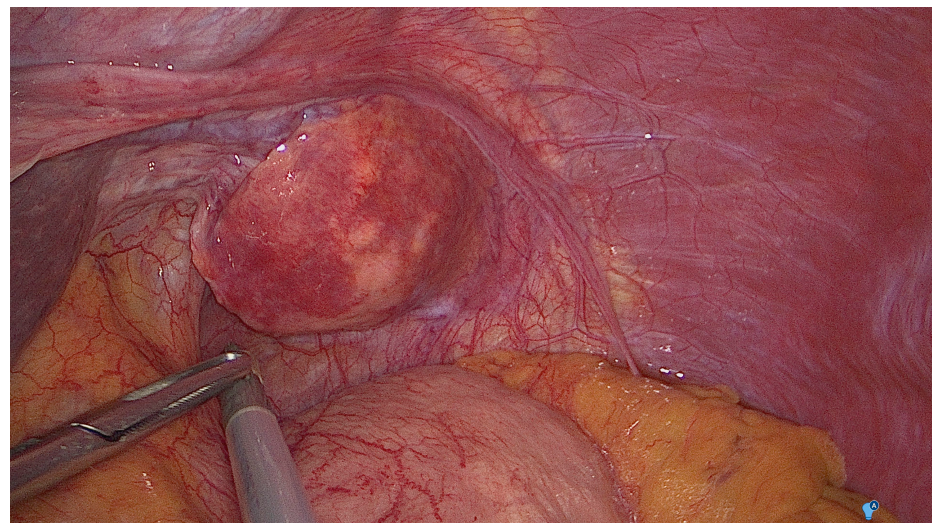
Figure 2. Intraoperative findings. Between the anterior gastric wall and the diaphragm muscle, the ovaloid mass is clearly visible within an accessory liver lobe. LHL: left hepatic lobe; AGW: anterior gastric wall; HCC: hepatocellular carcinoma.